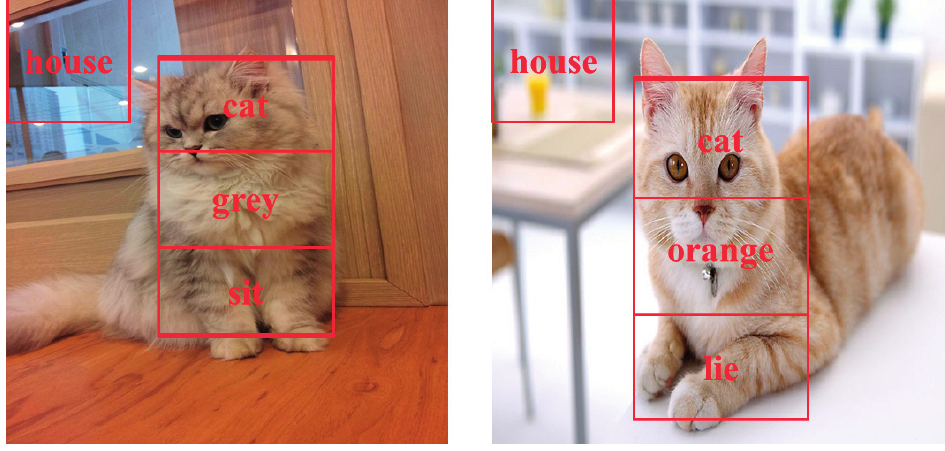
Figure 3. Scenes and